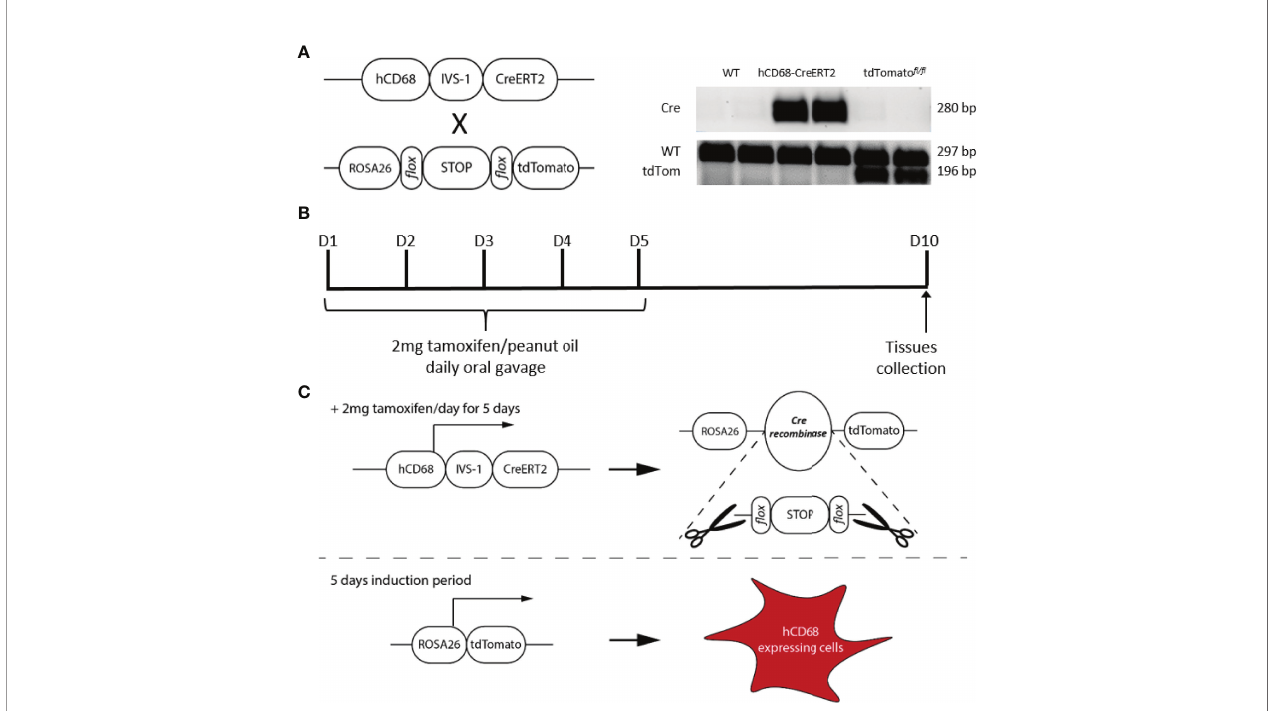
FIGURE 1 | Design and generation of the inducible hCD68-CreERT2 model. (A) Presence of Cre recombinase and tdTomato genes was con fi rmed by extracting DNA from ear notches, a standard PCR ampli fi cation and running side-by-side on an agarose gel for all genotypes available for het x het breeding strategy (see methods for details). (B) Tamoxifen dosing protocol for induction of Cre recombinase activity in hCD68-CreERT2 model. (C) Principles of the human CD68 promoter- driven tamoxifen inducible Cre recombinase activation; not to